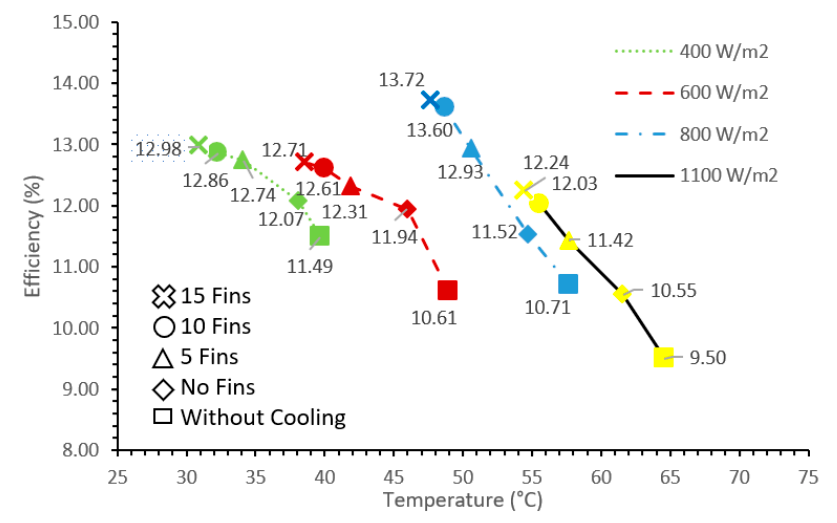
Figure 6. Graph of the relationship between working temperature and efficiency.